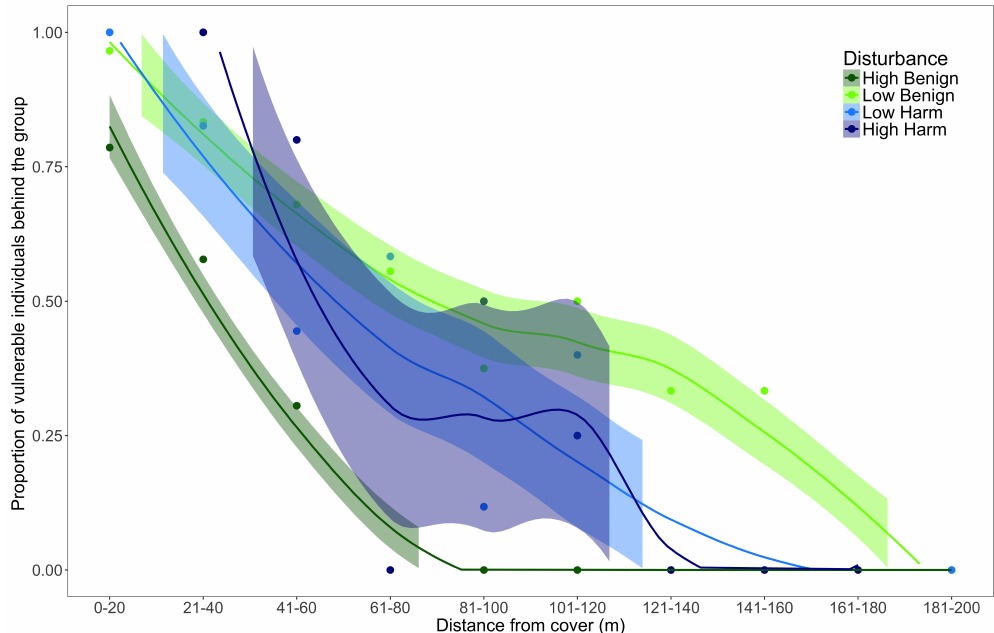
Figure 4. The relationship between the proportion of mothers, pouch young, and young-at-foot (vulnerable individuals) positioned closer to the forest edge and the group’s distance from cover. The relationships are plotted for each disturbance type with shaded regions reflecting confidence intervals (95%).